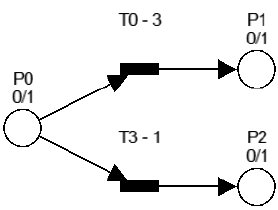
Figure 4. Petri Net model with weighted transitions.